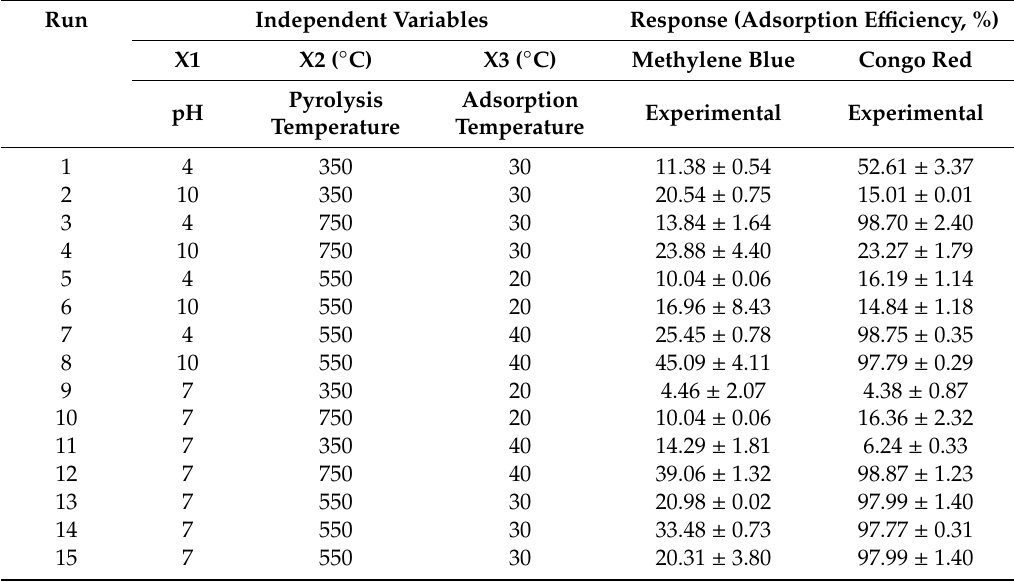
Table 3. E ff ects of di ff erent combinations of various variables on adsorption e ffi ciency (%) of methylene blue and congo red analyzed by using a Box-Behnken response surface